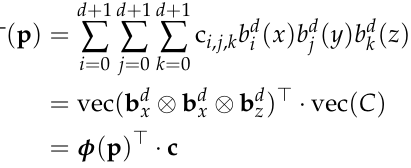
q n and denoted as t ¯ p . t q { t }